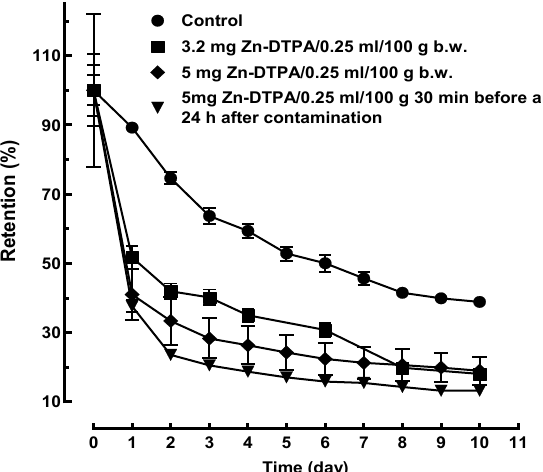
Figure 2. Time-course of 65 Zn decorporation following rapid intervention with Zn-DTPA in rats. Data points represent means ± SEM ( n = 7).